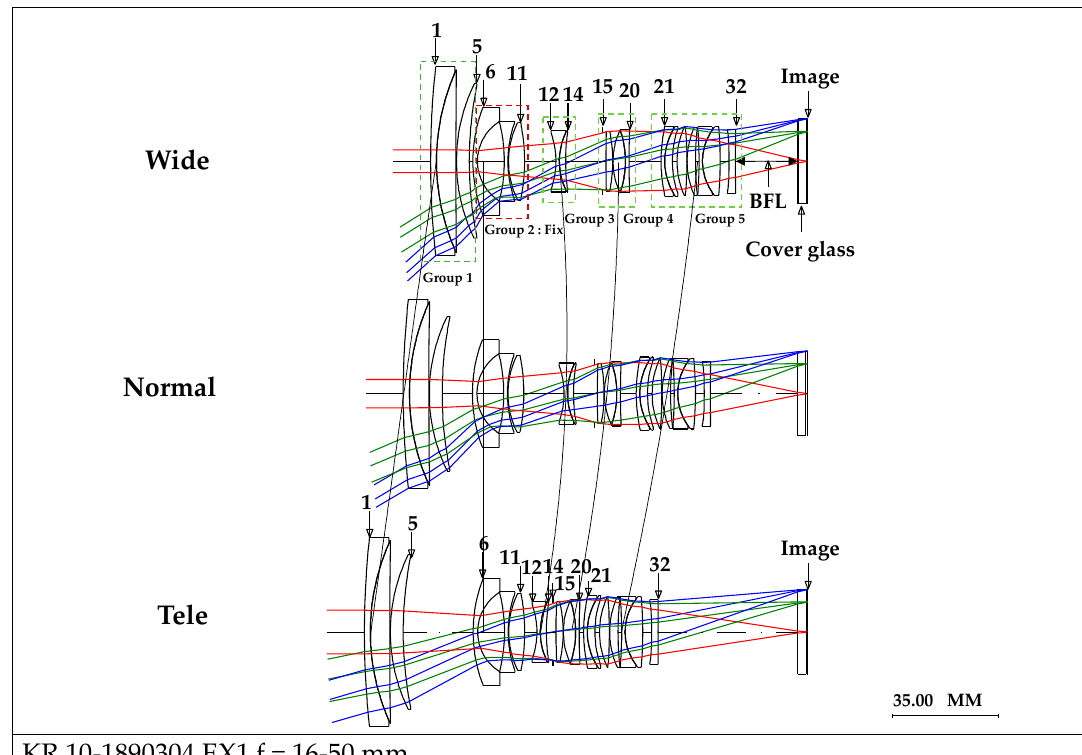
Figure 5. Optical layout of the first example in KR10-1890304 [16]. Table 3. Results of Padé approximation assuming the first lens group moves linearly.